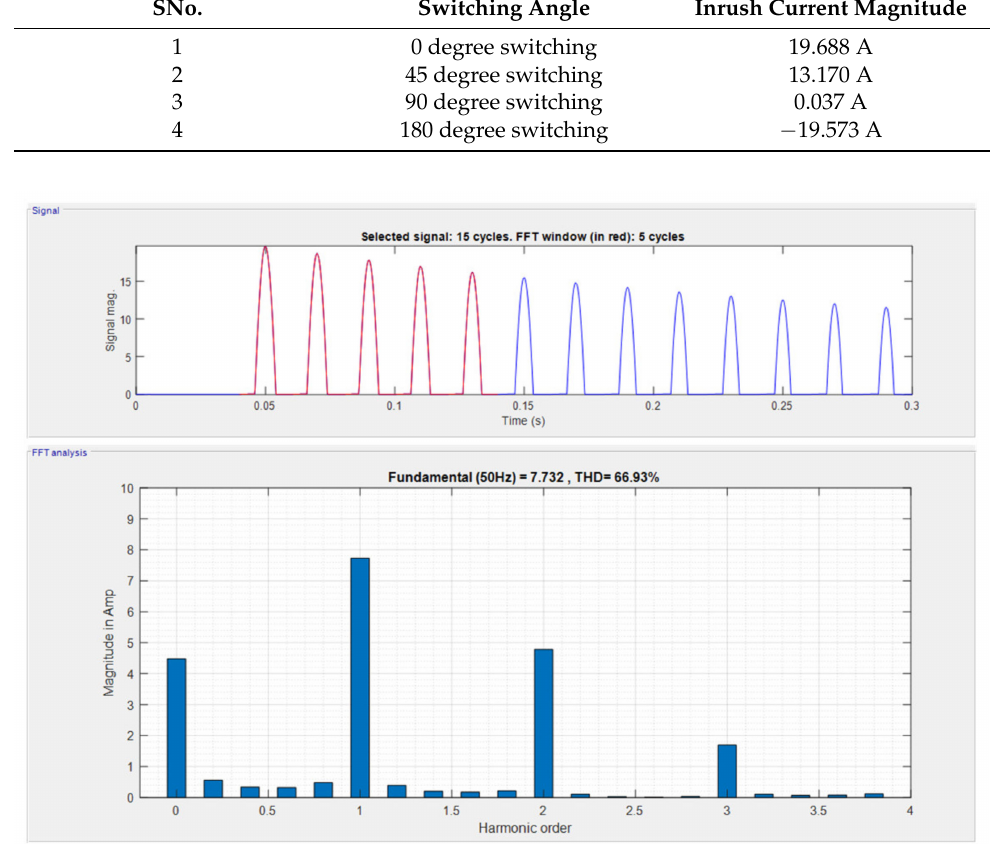
Figure 10. Analysis of inrush current using FFT for old